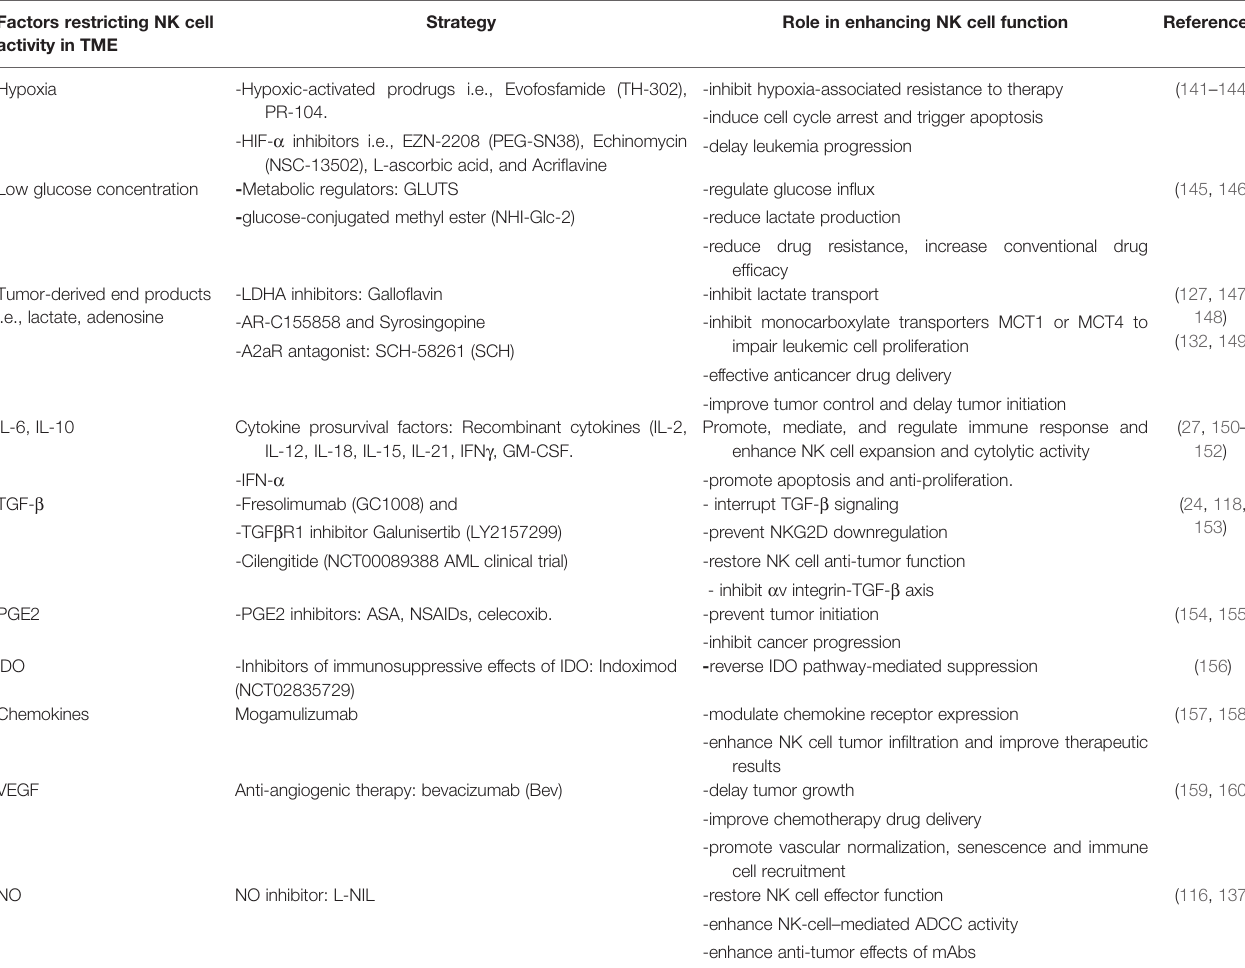
TABLE 1 | Strategies to circumvent immunosuppressive factors in the TME and their role in restoring NK cell function. Factors restricting NK cell activity in